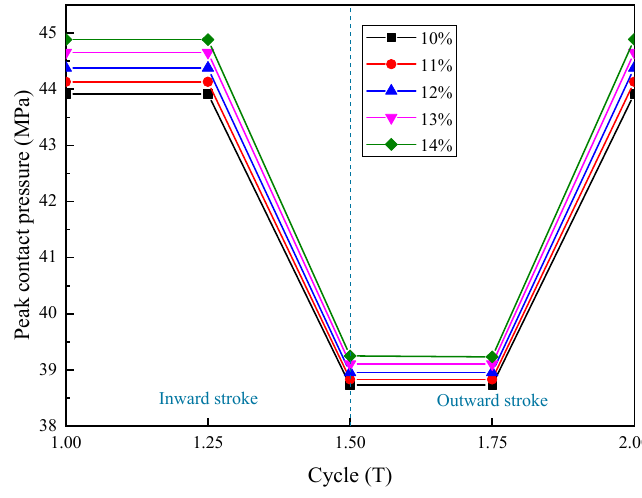
Figure 15. The relationship between peak contact pressure and R p during 1–2 T.